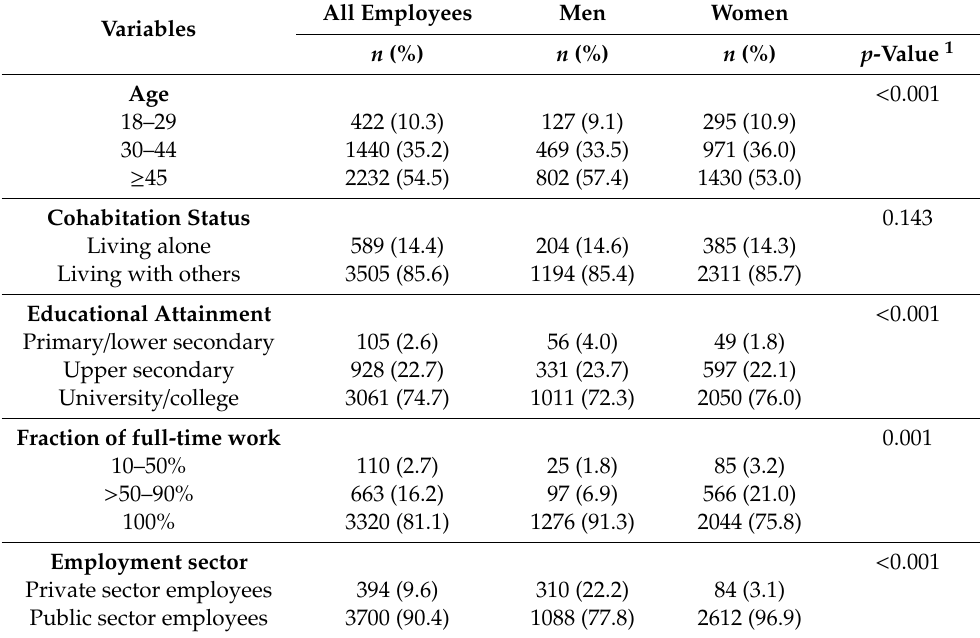
Table 1. Sample characteristics of all employees ( N = 4094) and stratified by gender (men: n = 1398; women: n =